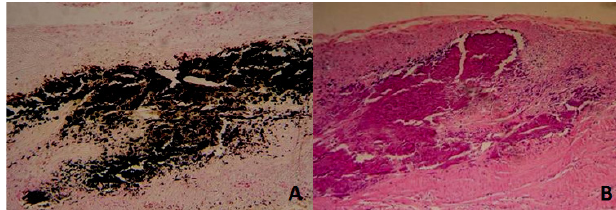
Fig. 5 - Histological calcification between groups. A) Study bovine pericardium; B) control bovine